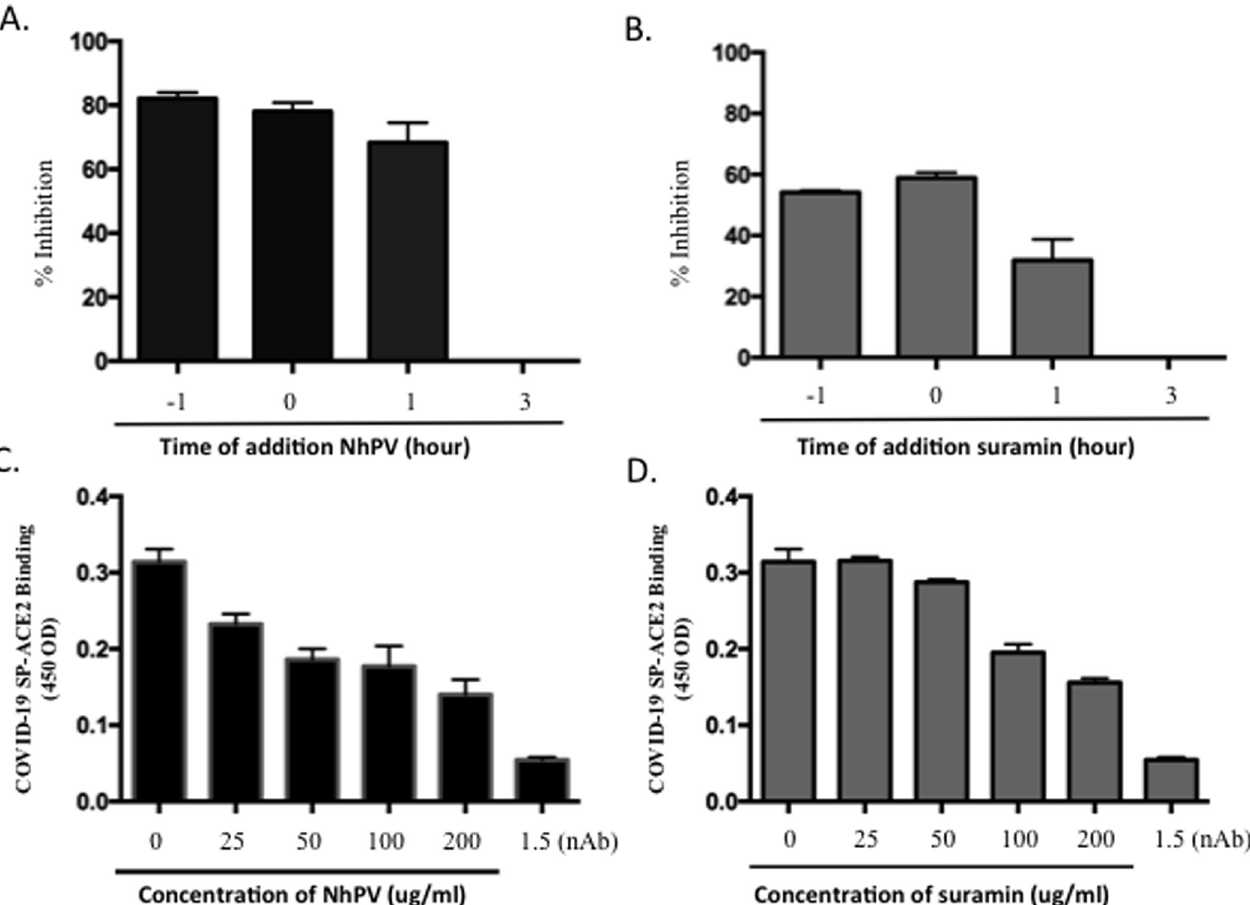
Fig 4. Characterization of the mechanisms of NhPV and Suramin for their anti-SARS-CoV-2-SP action. A) Time-dependent inhibition of SP Δ C G614 -PVs infection mediated by NhPV or Suramin. NhPV (100 μ g/mL) or Suramin (100 μ g/mL) was added at 1 hr prior to infection, during infection (0 hr), and at 1 hr, and 3 hr pi. The positive controls (P.C.) were 293T ACE2 cells infected with SP Δ C G614 -PVs in the absence of compounds. At 3 hrs pi, all of the cell cultures were replaced with fresh DMEM and cultured for 48 hrs. Then, the Gluc activity was monitored in the supernatant, and the data are shown as a percentage of inhibition (%). B) Inhibitory effect of NhPV or Suramin on SARS-CoV2-SP/ACE2 binding by ELISA as described in materials and methods. nAB: anti- COVID-19 neutralizing antibody (SAD-S35). The results are the mean ± S.D. of duplicate samples, and the data are representative of results obtained in two independent